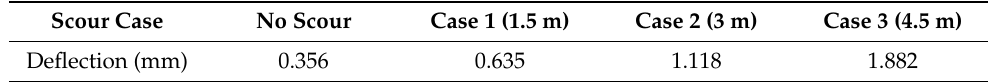
Figure 11. Lateral displacement vs. depth for no scour and scour cases 1–3. Table 5. Pile-head deflection (mm) resulted from FEM modeling.